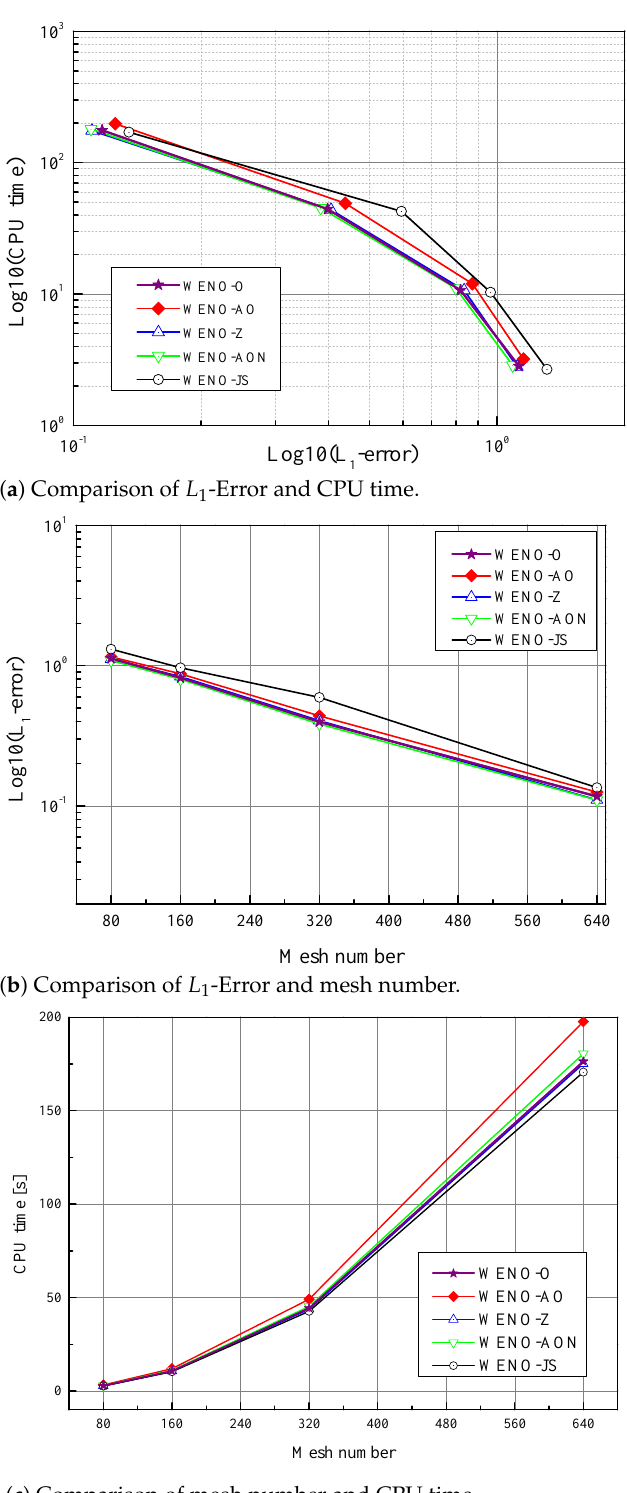
Figure 17. The accuracy comparison of considered WENO schemes for Shu–Osher problem of Example 6 (Section 6.2.3) for density field at time t = 1.8, CFL = 0.1 with 320